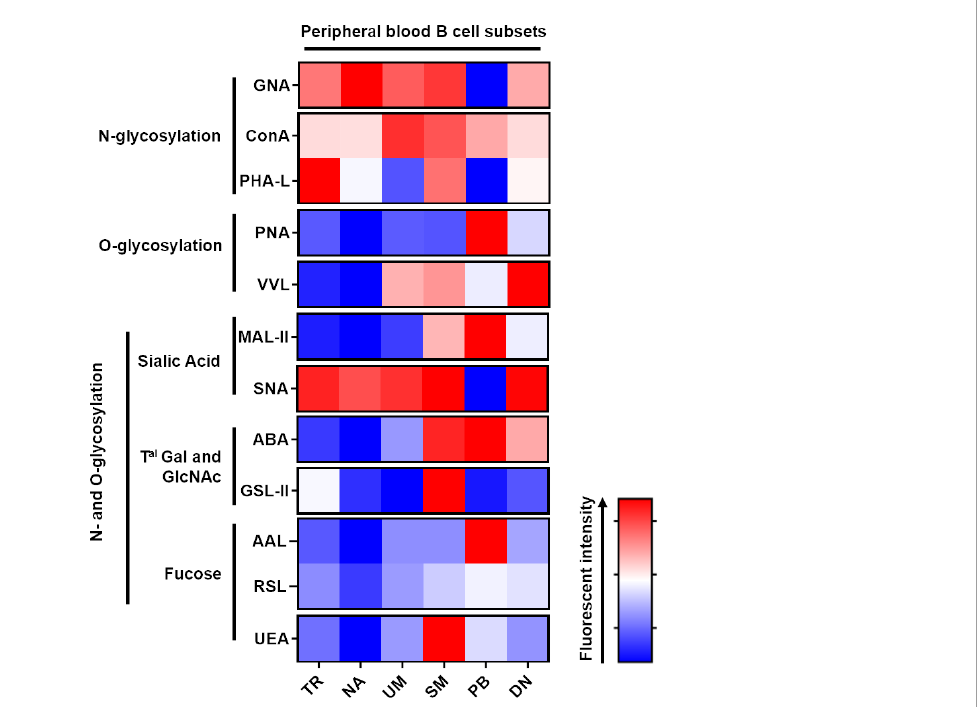
FIGURE 4 Peripheral blood B cell differentiation is associated with a rearrangement of N and O-glycan surface and an increase of Galactose a 2-3 N- acetylneuraminic acid residues. Freshly isolated peripheral blood mononuclear cells (PBMC) were stained with lectins the speci fi c B cell antibody panel before analysis using Beckman Coulter Cyto fl ex S. Fluorescence intensity is expressed as geomean. All the listed annotation stands for; TR: Transitional B cells; NA: Naive B cells; UM: Unswitched-memory B cells; SM: Switched-memory B cells; PB: Plasmablasts and DN: Double negative (CD27 - IgD - ) B cells; Gal: Galactose; Tal: terminal; GlcNAc: N-acetylglucosamine. Freshly isolated tonsillar mononuclear cells were stained with lectins (Table 2) and the speci fi c B cell antibody